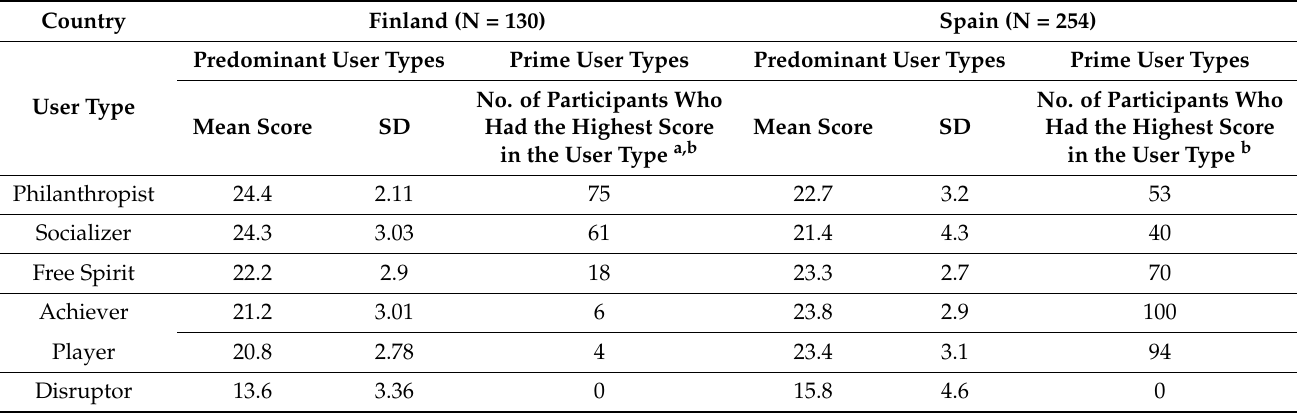
Table 2. Distribution of user types among participants (N_Finland = 130, N_Spain =